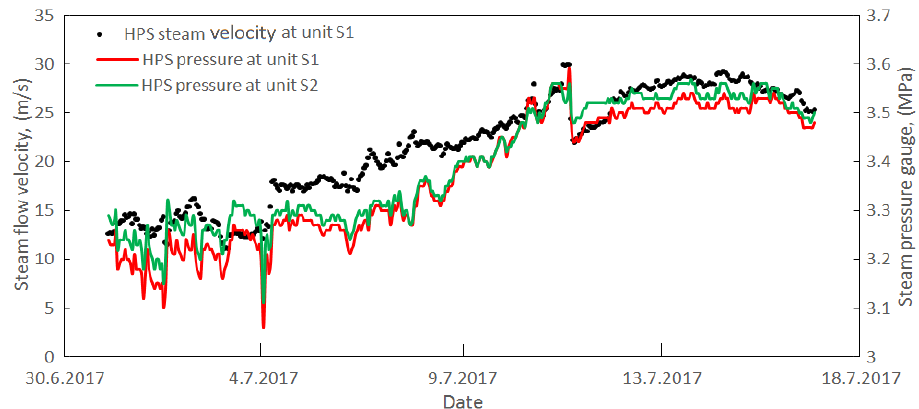
Figure 9. Time course of HPS flow velocity at S2 unit and HPS pressure at battery limit of units S2 and S1 during the time period from 1.7.2017 to 17.7.2017.